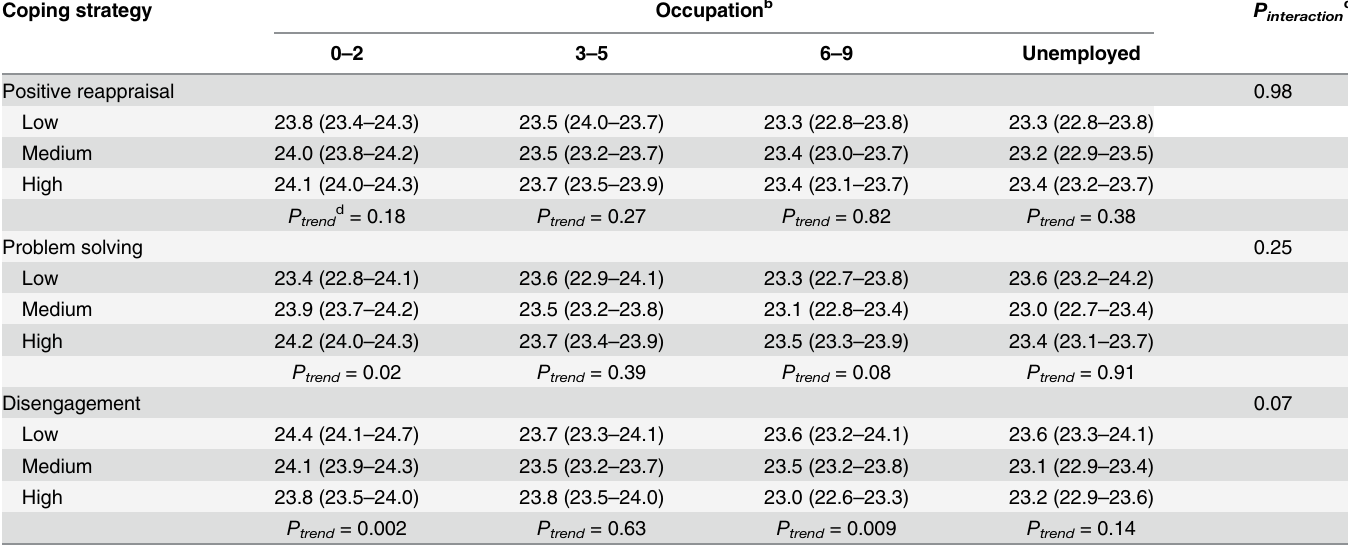
Table 4. Adjusted means a (and 95% con fi dence intervals) of body mass index (kg/m 2 ) by selected coping strategies and occupation in 5,063 men — Japan, 2005 –